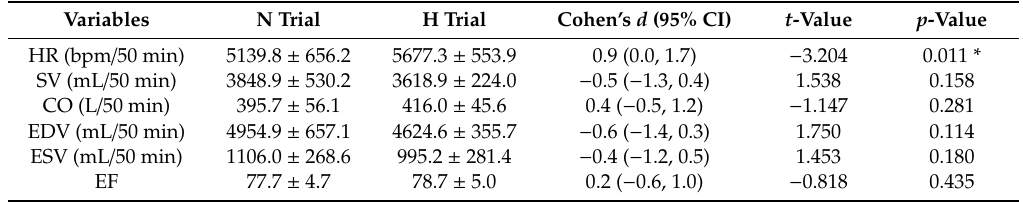
Table 2. Cardiac function parameters during the Pilates program in the N trial and H